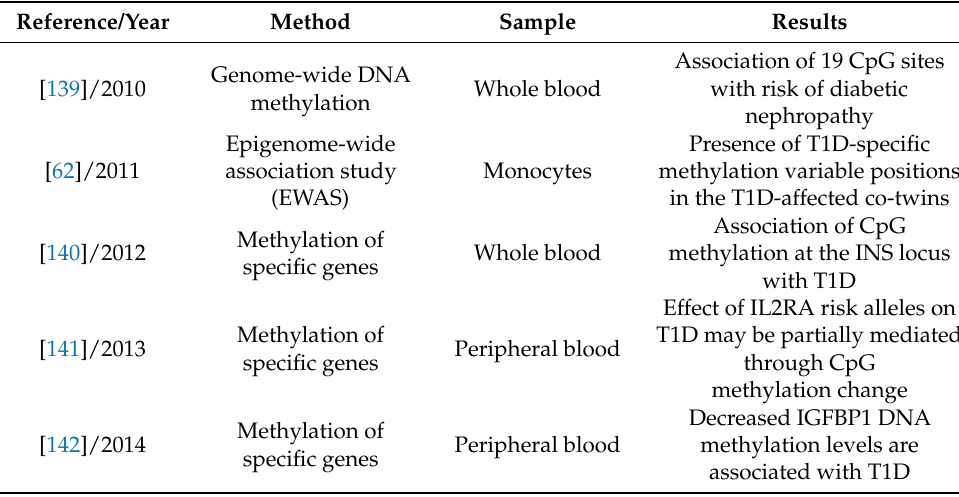
Table 1. Studies on DNA methylation and type 1